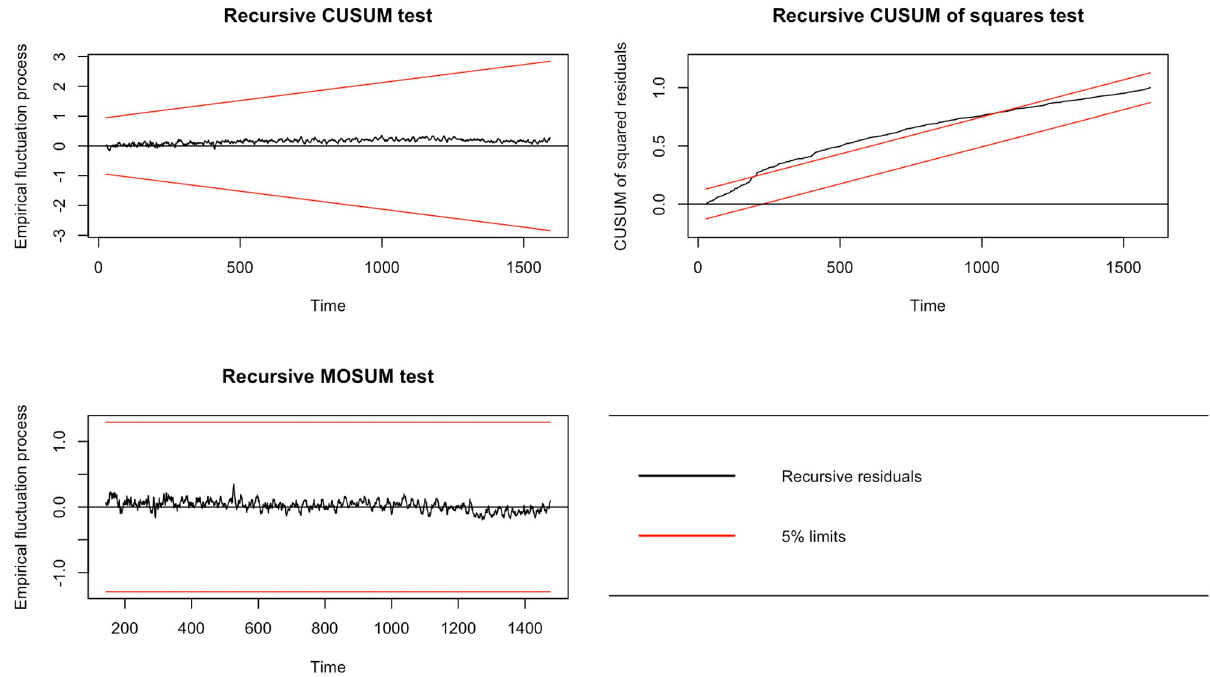
Fig 2. Recursive CUSUM, CUSUM of squares and MOSUM plots for the model stability.